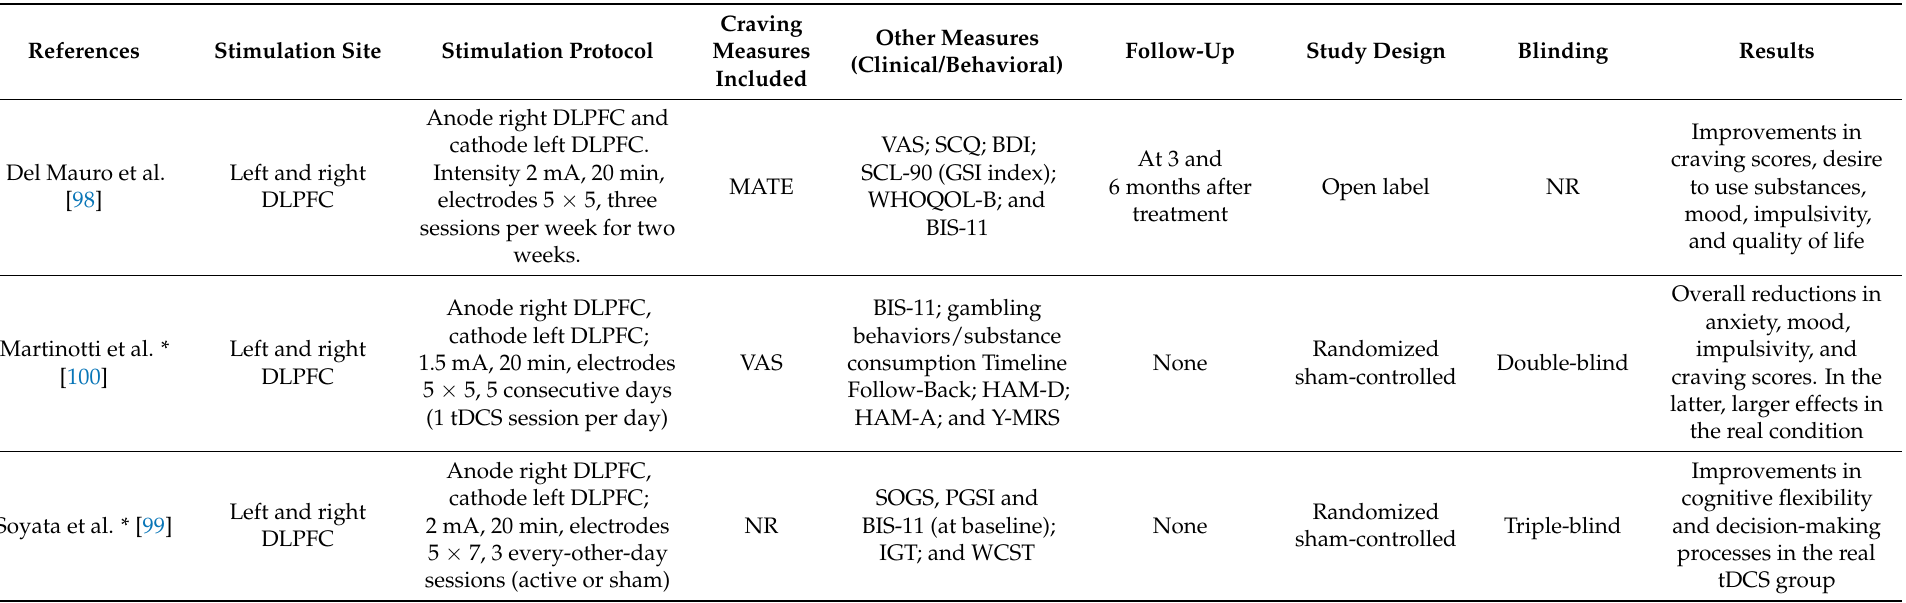
Table 4. Detailed information about tDCS studies protocols and